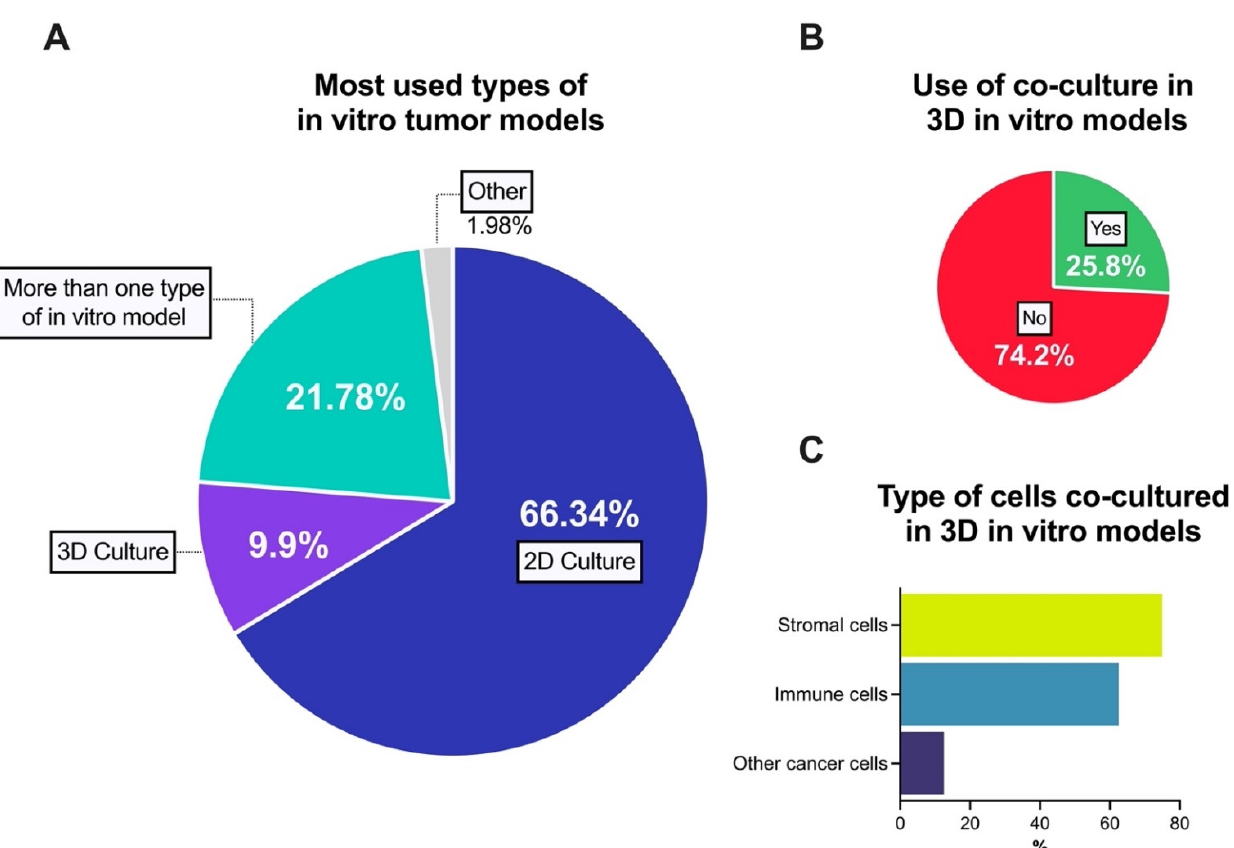
Figure 4. Use of 3D in vitro models in pre-clinical cancer research. ( A ) Main in vitro tumor models; ( B ) Use of co-cultured approach related to 3D in vitro tumor models; ( C ) Most used cell types to co-culture with cancer cells in 3D in vitro tumor models. Note: Figure 4C represents a question with multiple choice. Some respondents indicate that their co-culture models involved more than one type of cell.